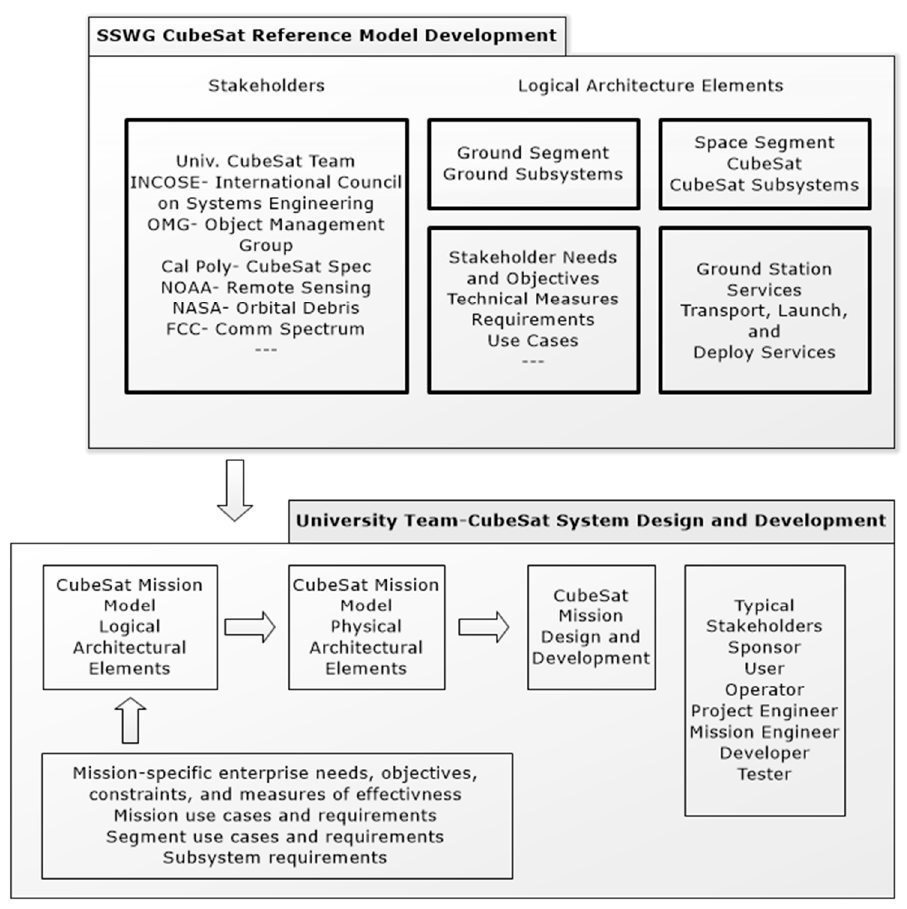
Figure 6. The Space Systems Working Group (SSWG)-CubeSat reference model (based on [32,33]).